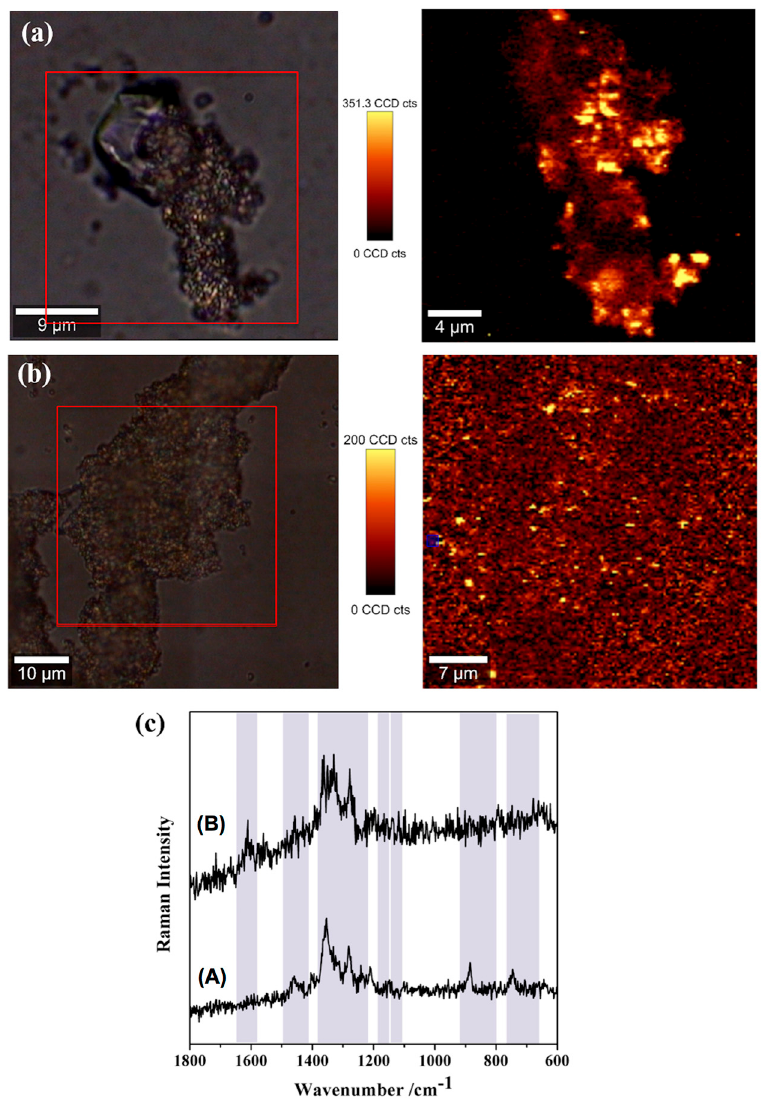
Figure 11. Raman images obtained using the integrated intensity of the band at 1347 cm − 1 in the SERS spectra of TC (10 µ M) recorded using the MNP-AuNS as substrates (excitation at 633 nm, 0.2 mW laser power) for the TC spiked samples: ( a ) estuarine water from Aveiro lagoon and ( b ) mineral water. The respective optical images of the samples are on the left side, with the scanned area marked in red. The vertical bar shows the colour profile in each image, with the relative intensity scale; and ( c ) single SERS spectrum for TC (10 µ M) using MNP-AuNS obtained from the Raman images above for (A) estuarine water from Aveiro lagoon and (B) mineral water.